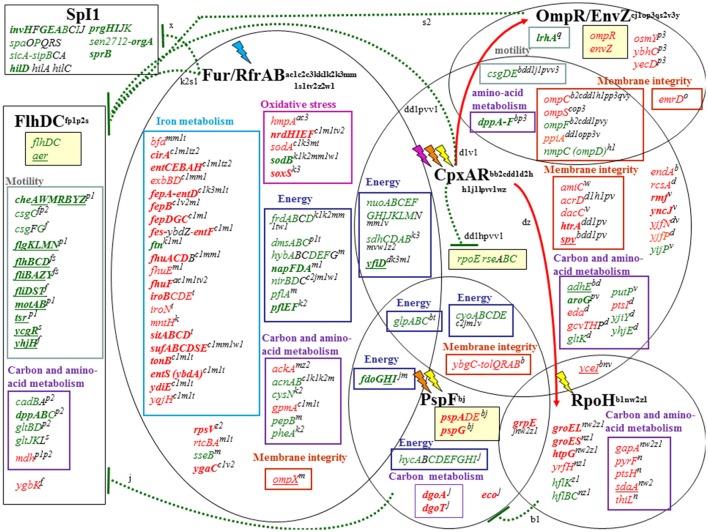
Summary of the major global regulatory responses of S. Enteritidis to bacteriocidal egg white exposure. Each regulon is represented by black elipses and lighting symbols represent the stimuli that activate regulator responses: pink for antimicrobial molecules, orange for alkaline stress, yellow for thermal stress and blue for low iron conditions. Up-regulated, down-regulated and non-regulated genes are represented in red, green or black, respectively. Genes with a ≥fourfold change in expression are in bold. Genes underlined are identified as up or down regulated by alkaline pH (Maurer et al., 2005). Red arrows and green broken lines indicate, respectively, activation (red) and repression (green) by corresponding regulators: the origin of the arrows indicates the regulator involved. In each regulon, genes are grouped in boxes depending of the metabolic pathway to which they belong: iron metabolism (turquoise), oxidative stress (fuchsia), energy (dark blue), carbon and amino-acid metabolism (purple), motility (gray) and membrane integrity (orange). Genes previously reported to be regulated by the corresponding regulators are indicated by uppercase letters with the following designations: Brissette et al., 1991 [b1]; Stojiljkovic et al., 1994 [s1]; Crawford and Goldberg, 1998 [c3]; Danese and Silhavy, 1998 [d2]; Vassinova and Kozyrev, 2000 [v2]; Prüß et al., 2001 [p1]; D'Autréaux et al., 2002 [a]; De Wulf et al., 2002 [d]; Kehres et al., 2002 [k]; Oshima et al., 2002 [o]; McHugh et al., 2003 [m1]; Prüß et al., 2003 [p2]; Humphreys et al., 2004 [h]; Batchelor et al., 2005 [b2]; Jubelin et al., 2005 [j1]; Massé et al., 2005 [m]; Stafford et al., 2005 [s]; Vianney, 2005 [v3]; Zhao et al., 2005 [z1]; Zhang et al., 2005 [z2]; Dorel et al., 2006 [d1]; Jovanovic et al., 2006 [j]; Nonaka et al., 2006 [n]; Wade et al., 2006 [w2]; Yoshida et al., 2006 [y]; Zahrl et al., 2006 [z]; Chen et al., 2007 [c1]; Bury-Moné et al., 2009 [b]; Price and Raivio, 2009 [p]; Perkins et al., 2009 [p3]; De la Cruz and Calva, 2010 [c]; Hu et al., 2011 [h1]; Kumar and Shimizu, 2011 [k3]; Weatherspoon-Griffin et al., 2011 [w]; Troxell et al., 2011 [t]; Teixidó et al., 2011 [x]; Lin et al., 2012 [l]; Kim and Kwon, 2013a [k1]; Kim and Kwon, 2013b [k2]; Samanta et al., 2013 [s2]; Raivio et al., 2013 [v]; Wright et al., 2013 [w1]; Calderón et al., 2014 [c2]; Fitzgerald et al., 2014 [f]; Quinn et al., 2014 [q]; Raivio, 2014 [v1].